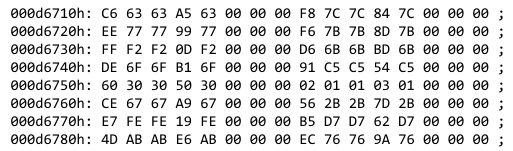
in the binary file of Libgcrypt-1.6.3. 0